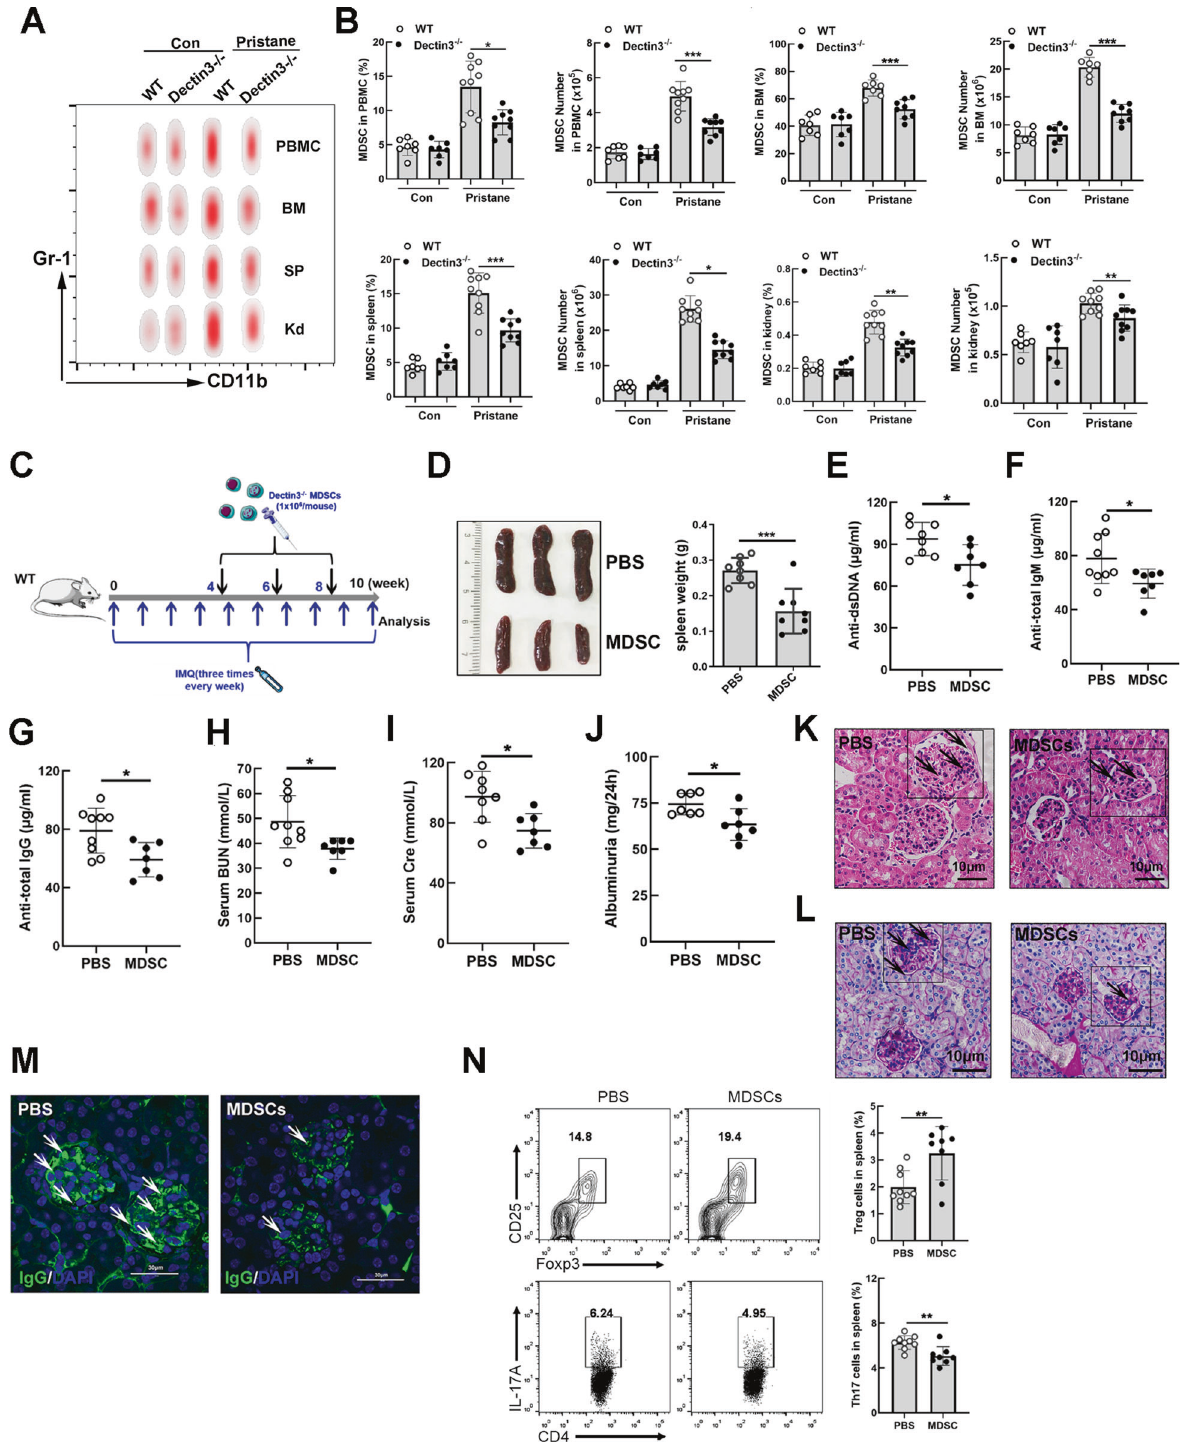
Fig. 2 Adoptive transfer of MDSCs from Dectin3 − / − mice with lupus alleviated the induction of lupus-like disease. A Representative fl ow cytometry results of MDSCs in PBMC, BM, SP, and Kd of each group. B Statistical data of percentages and absolute counts of MDSCs in PBMC, BM, SP, and Kd. C Schematic diagram of the adoptive transfer of MDSCs. D Representative photographs of the spleen and spleen weights in the MDSC and PBS groups. E – I ELISA of the serum levels of anti-dsDNA, anti-total IgM, IgG, BUN, and Cre in the MDSC and PBS groups. J The level of 24-h mouse urine protein was measured using ELISA. K , L HE and PAS staining of kidney sections in the MDSC and PBS groups (scale bar = 10 μ M). M Amounts of IgG deposits in glomeruli were measured using immuno fl uorescence analysis (scale bar = 30 μ M). N Flow cytometry analysis detected the percentages of Th17 and Treg cells. Data represent the mean scores ± SEM. * P ≤ 0.05, ** P ≤ 0.01, *** P ≤ 0.001; n = 7 – 9 mice in each group.